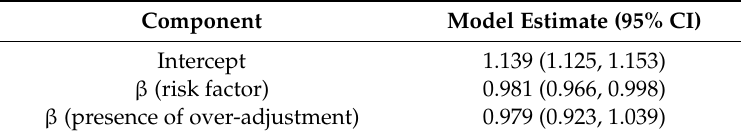
Table 7. Sensitivity analysis: the e ff ect of inclusion of the variables reflective of infection in the multivariate